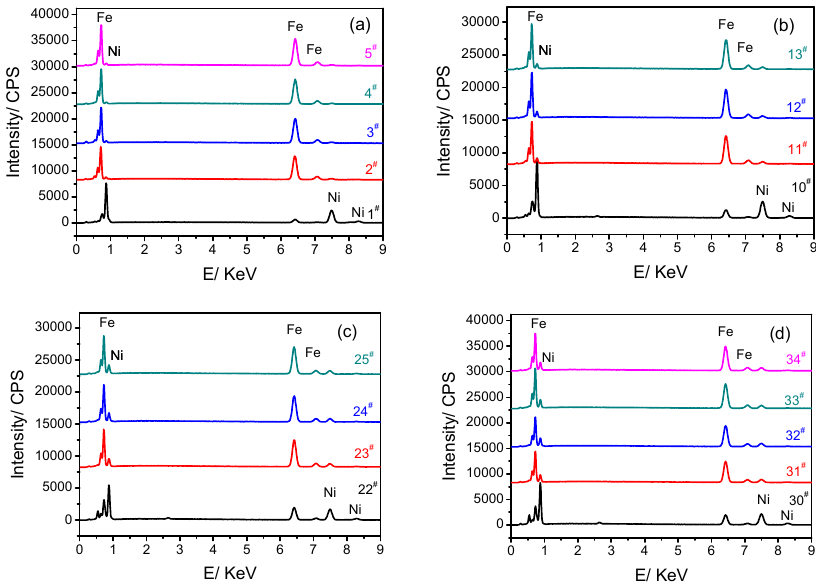
Figure 4. EDX spectra of Fe–Ni alloy foils electrodeposited from chloride baths contained different Ni 2+ ion concentrations of ( a ) 0.1 M, for 1 # to 5 # samples, ( b ) 0.3 M, for 10 # to 13 # samples, ( c ) 0.6 M, for 22 # to 25 # samples, and ( d ) 0.8 M, for 31 # to 34 # samples.